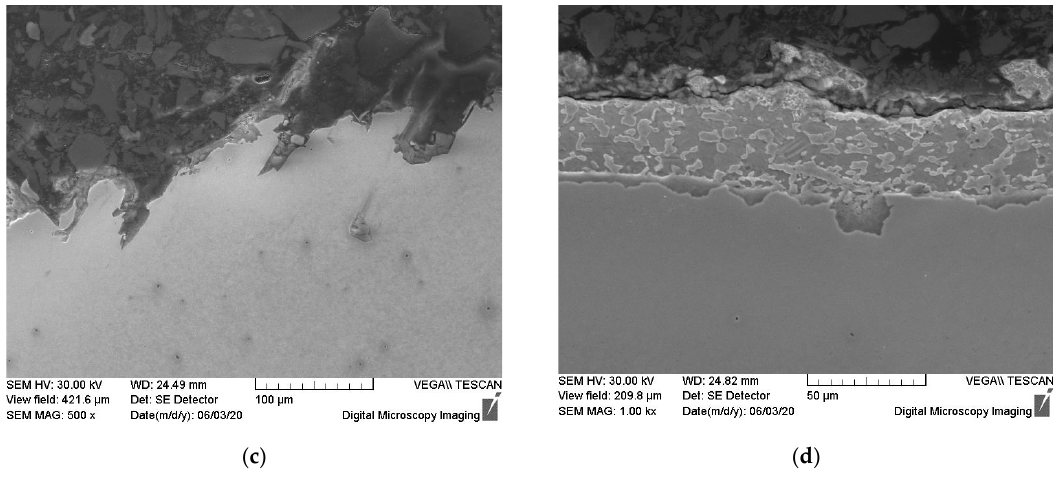
Figure 7. SEM images of wires: ( a ) galvanized—position 1, ( b ) galvanized—position 4, ( c ) compacted—position 1, ( d ) compacted—position 4.